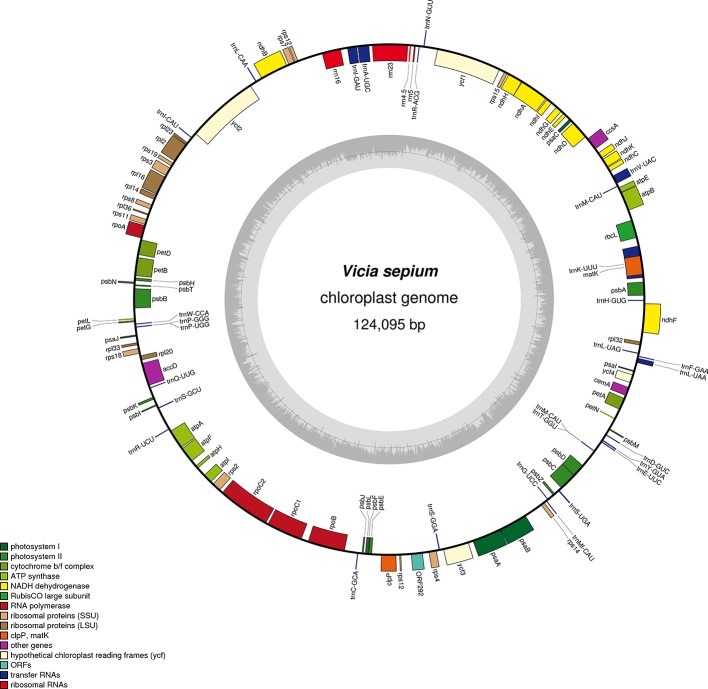
Gene map of the complete chloroplast genome of V. sepium. Genes inside the circle are transcribed clockwise, and those outside are transcribed counterclockwise. The different colors of the blocks represent different functional groups. The darker gray color of the inner circle corresponds to the GC content, and the lighter gray color corresponds to the AT content.